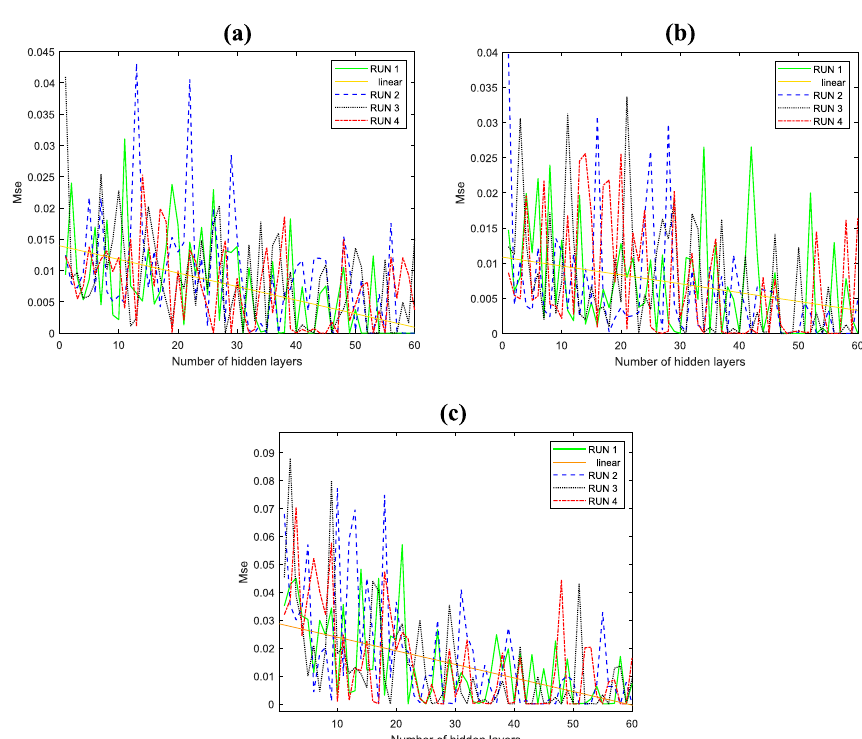
Fig. 2 The effect of the number of hidden layers on the mean squared error for results of a mean thrust force, b maximum thrust force, and c surface roughness Ra